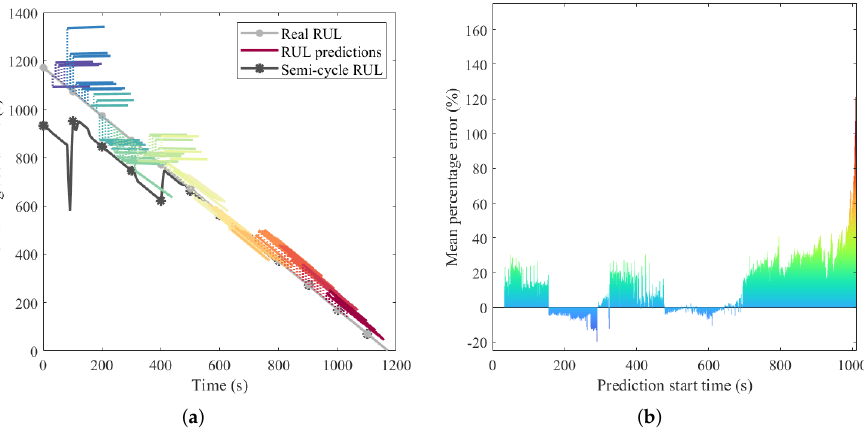
Figure 11. Predictions of the transformer network for the next 128 s. ( a ) RUL predictions. ( b ) The MPE of RUL predictions with different start time. The colored solid line represents the output value of the RUL prediction sequence in the next 128s. The point corresponding to the colored dotted line refers to the RUL prediction start time. The RUL is predicted every 10s after the 32s blank period to meet the maneuver decision-making needs for the full